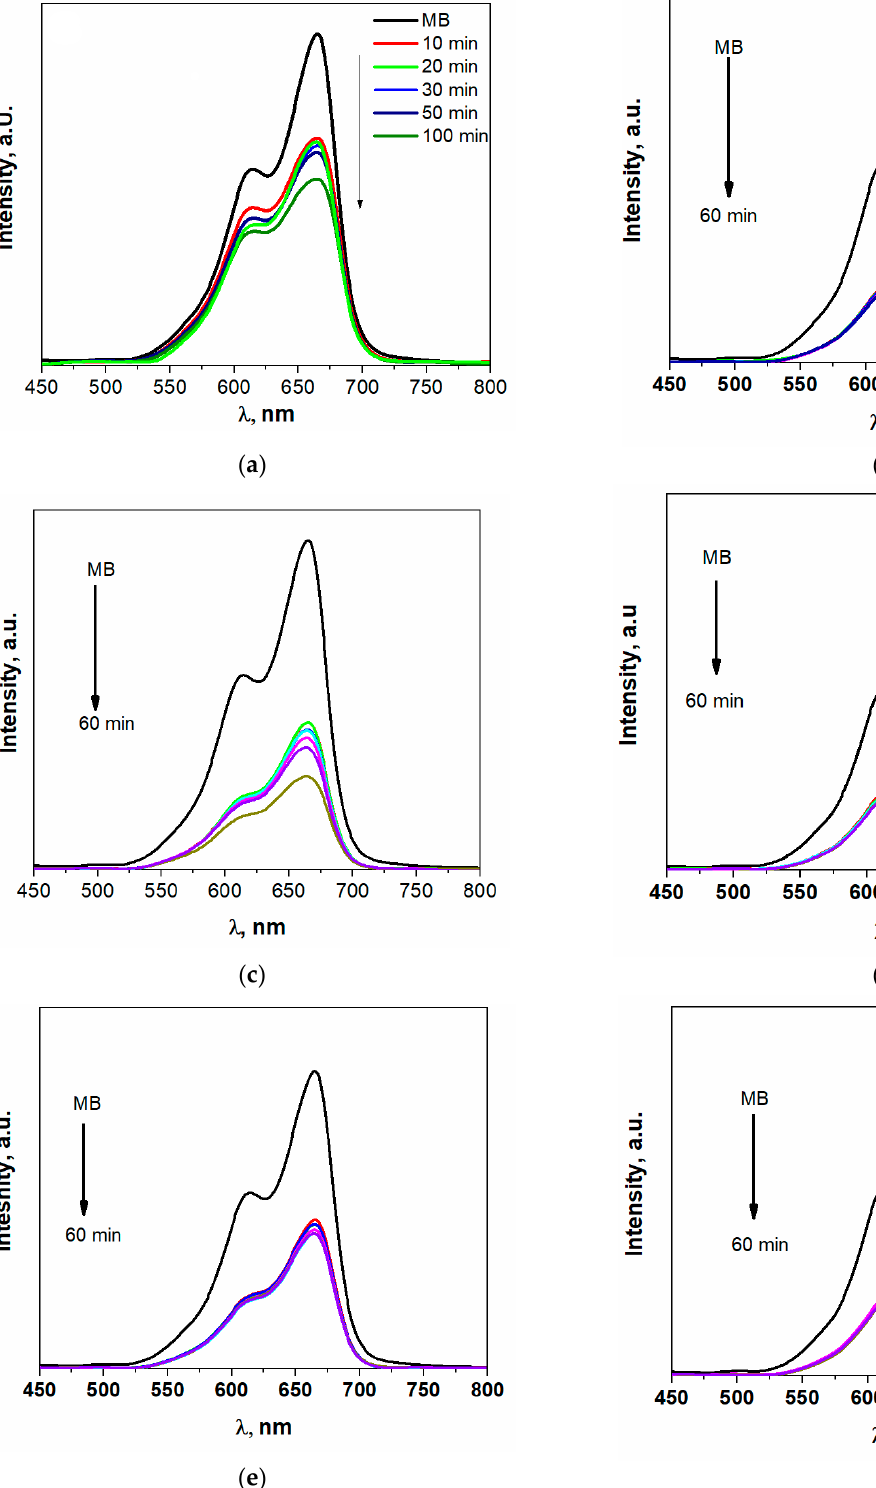
Figure 8. The photodegradation of M.B. by different concentrations of Fe in Zn 1 − x Fe x O ( a ) x = 0, ( b ) x = 0.03, ( c ) x = 0.05, ( d ) x = 0.07, ( e ) x = 0.1 and ( f ) x = 0.15.